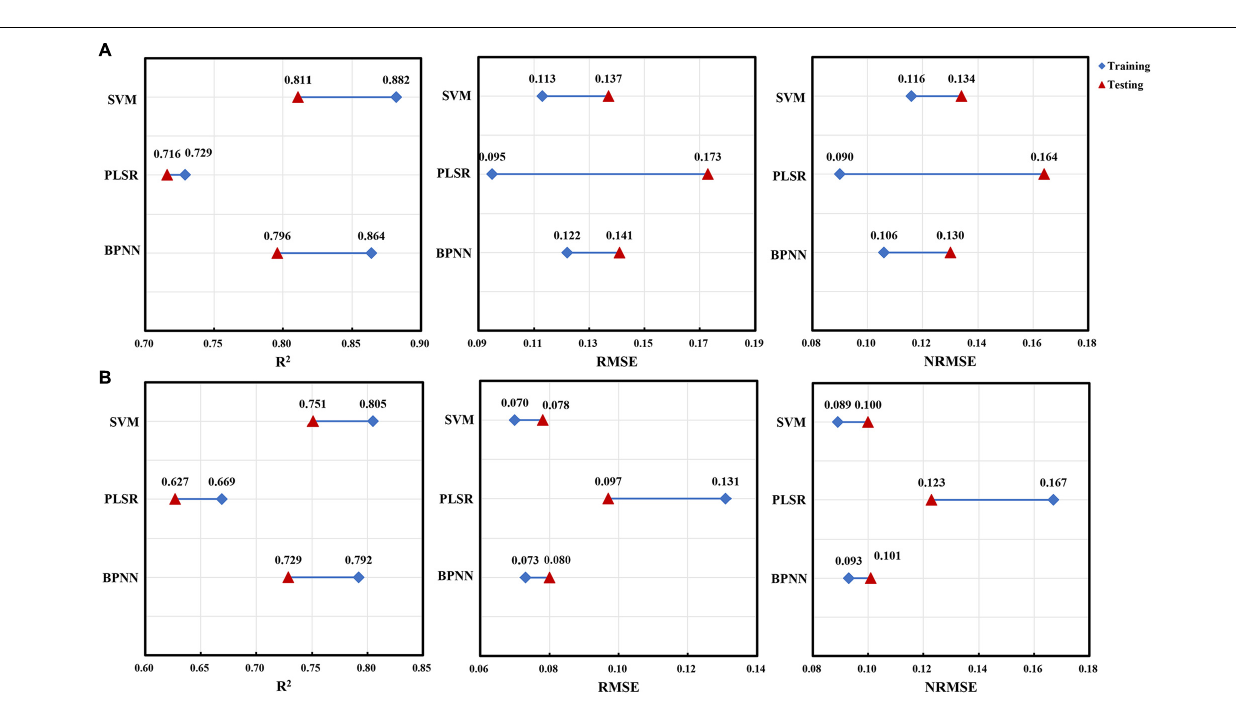
Frontiers in Plant Science |